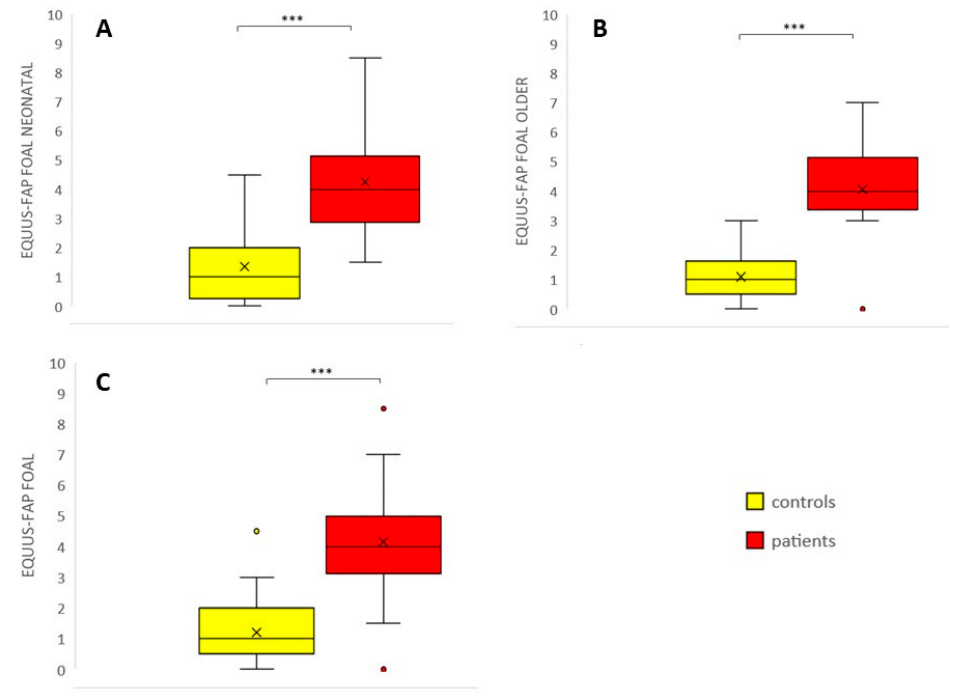
Figure 1. EQUUS-FAP FOAL (Equine Utrecht University Scale for Facial Pain Assessment for foals) patients versus controls; ( A ): EQUUS-FAP FOAL in neonatal foals (0–14 days) ( n = 10 patients, n = 17 controls); ( B ) EQUUS-FAP FOAL in older foals (14 days–6 months) ( n = 10 patients, n = 22 controls); ( C ): EQUUS-FAP FOAL in all foals ( n = 20 patients, n = 39 controls). Lines in boxes show median scores; boxes show 25–75th percentiles; error bars show 5–95th percentiles and outliers are shown as dots. *** = p < 0.001.